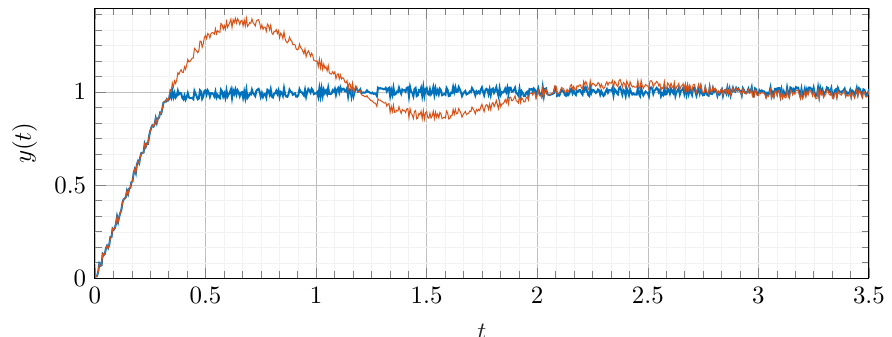
Figure 5. Closed-loop step response y under a reference change: (orange) base PI controllers; and (blue) PI + CI